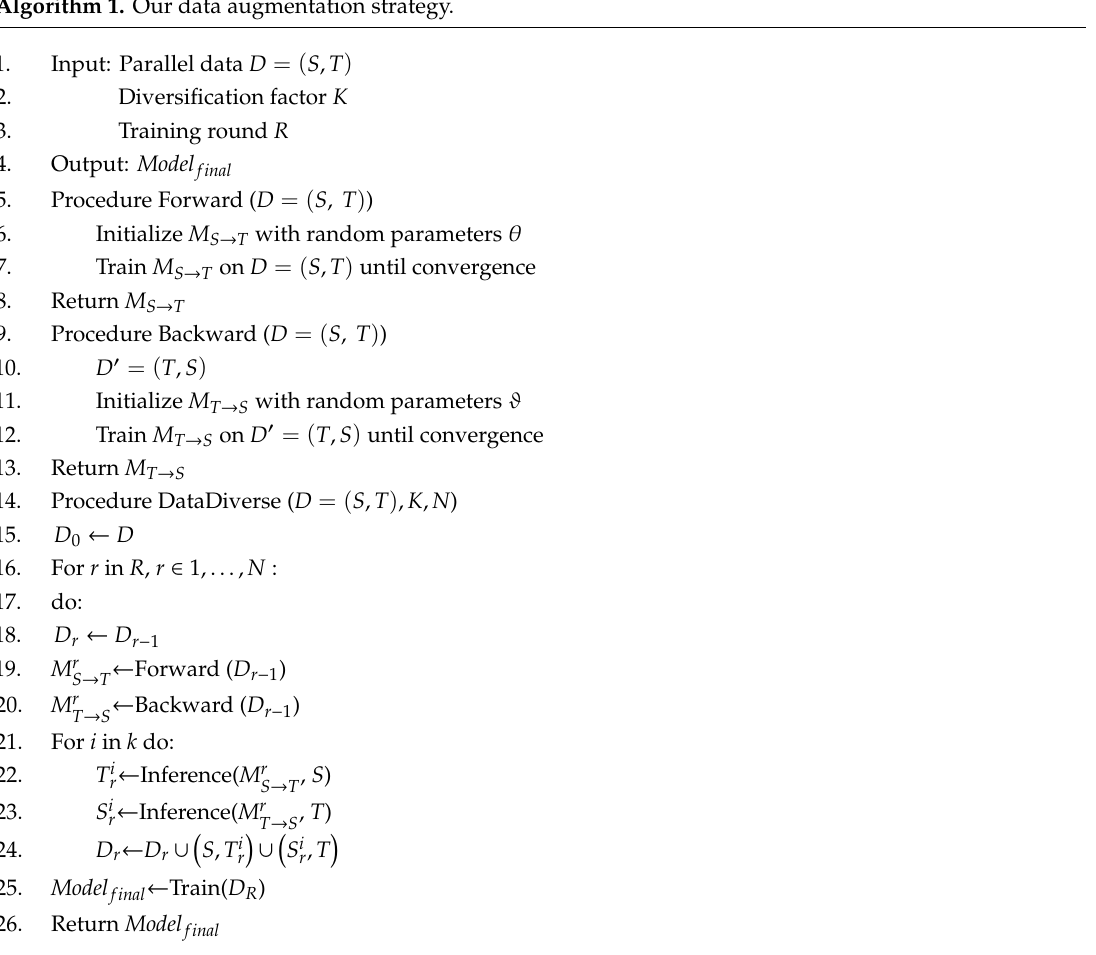
Algorithm 1. Our data augmentation